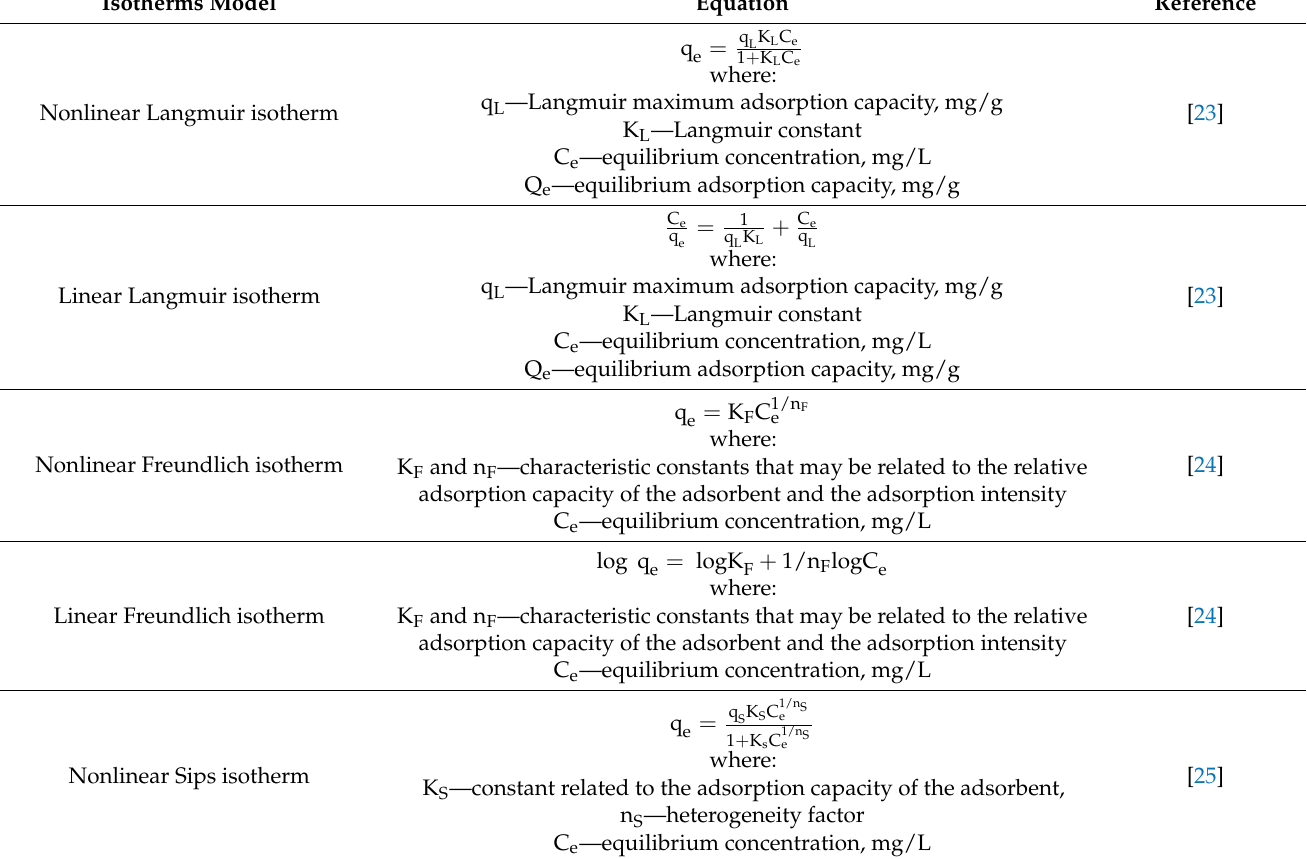
Table 2. Equilibrium